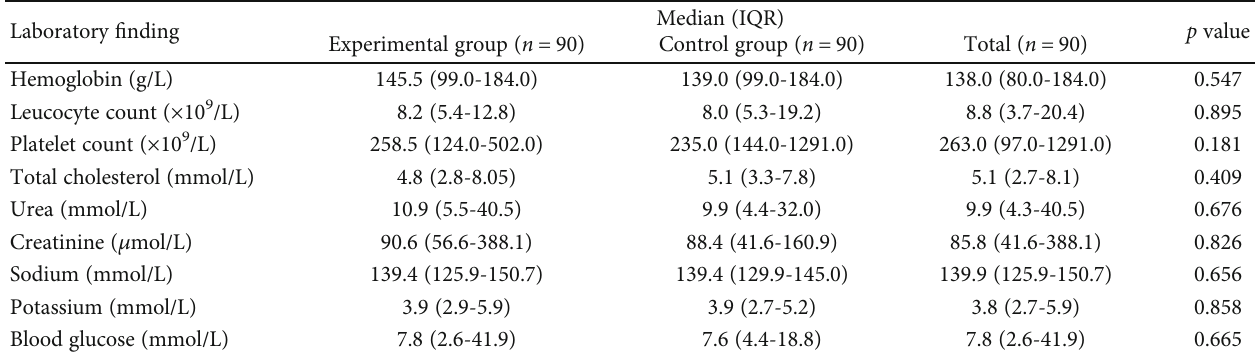
Table 2: Laboratory fi ndings of subjects.